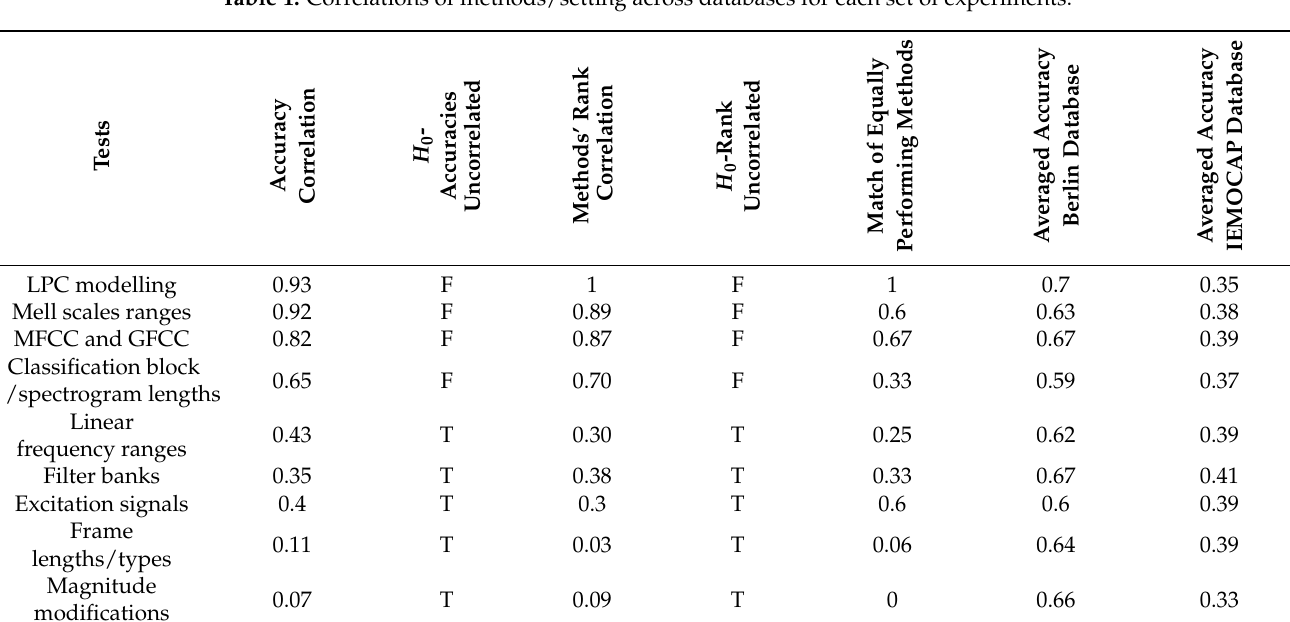
Table 1. Correlations of methods/setting across databases for each set of experiments.